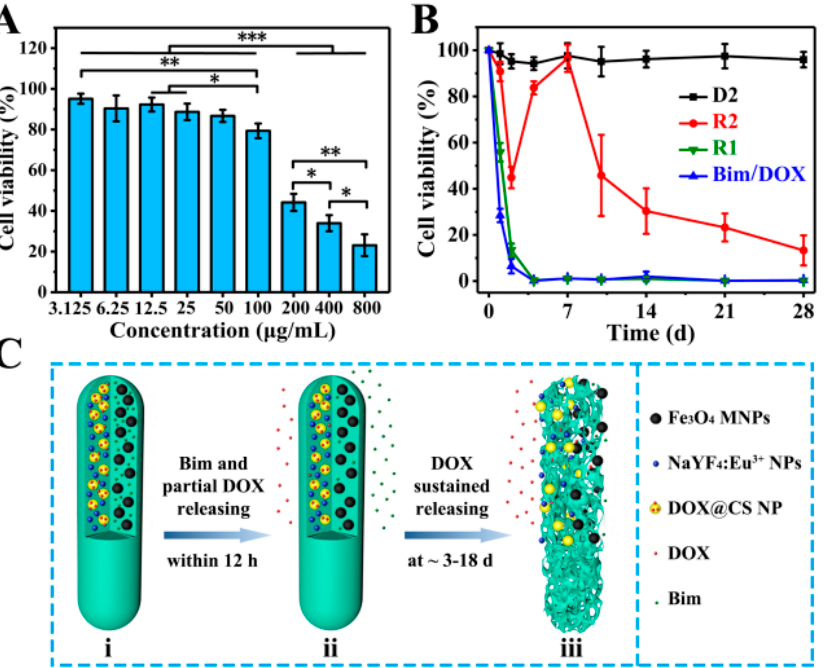
Figure 7. ( A ) In vitro A549 cell relative viabilities normalized to the untreated control after incubation for 48 h with different concentrations of R2 DDSs; * p < 0.05, ** p < 0.01, *** p < 0.001. ( B ) In vitro A549 cell relative viabilities normalized to the untreated control for 28 days with D2 DDCs, R1 and R2 DDSs, and drugs of Bim and DOX. ( C ) Schematic illustration of the release of two model drugs (Bim and DOX) from R2 DDSs: ( i ) R2 with Bim in left chamber and DOX@CS NPs in right chamber before drug release; ( ii ) Bim and partial DOX released within 12 h; ( iii ) the suspended release of DOX within ~3 to 18 days.